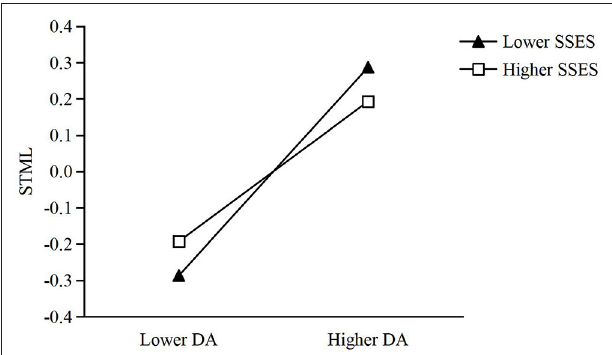
FIGURE 4 | Moderation effect of SSES in the relationship between DA and STML. SSES, subjective socioeconomic status; DA, dispositional awe; STML, self-transcendent meaning in